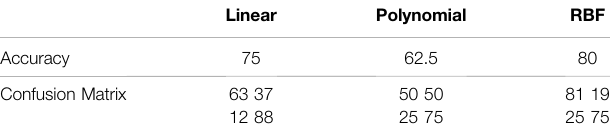
TABLE 4 | TD vs. ASD emotion changes from baseline and exit